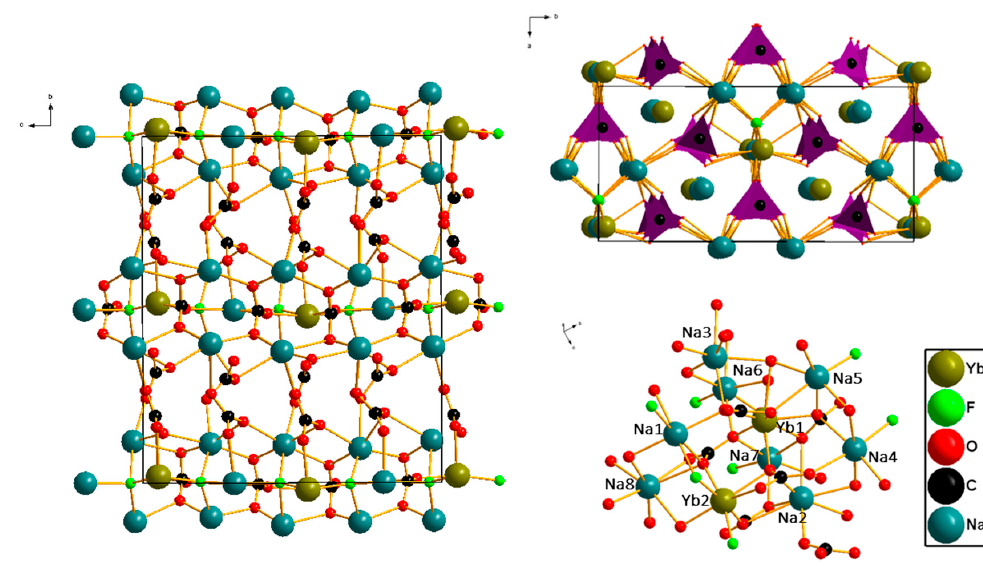
Figure 2. Crystal structure of Na 4 Yb(CO 3 ) 3 F.